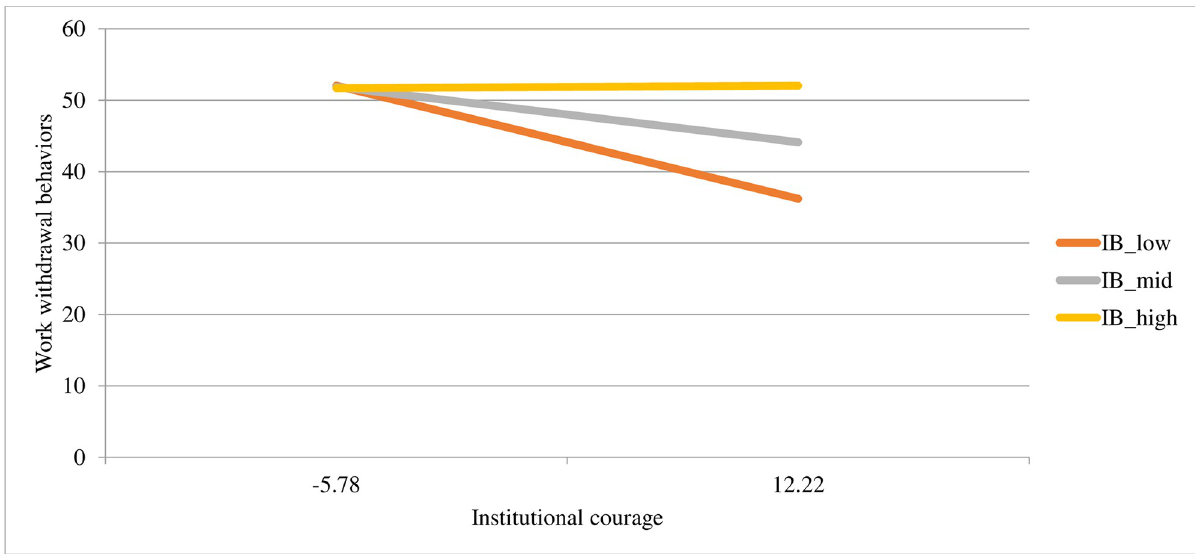
Fig 4. Associations of different levels of institutional courage (at -1SD, the mean, and +1SD) with work withdrawal at different levels of institutional betrayal (at -1SD and +1SD).